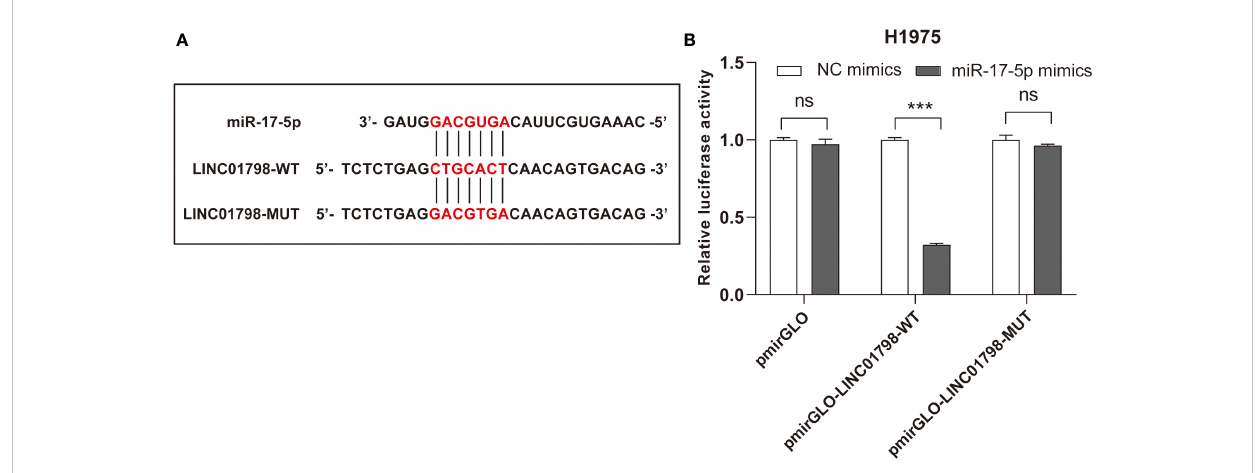
FIGURE 9 Reciprocal correlation between LINC01798 and miR-17-5p through the dual luciferase reporter assay. (A) The potential binding sites of miR-17-5p to the LINC01798 sequence. (B) The results of the dual luciferase reporter gene assay. *** p < 0.001, ns (not statistically signi fi cant) p >